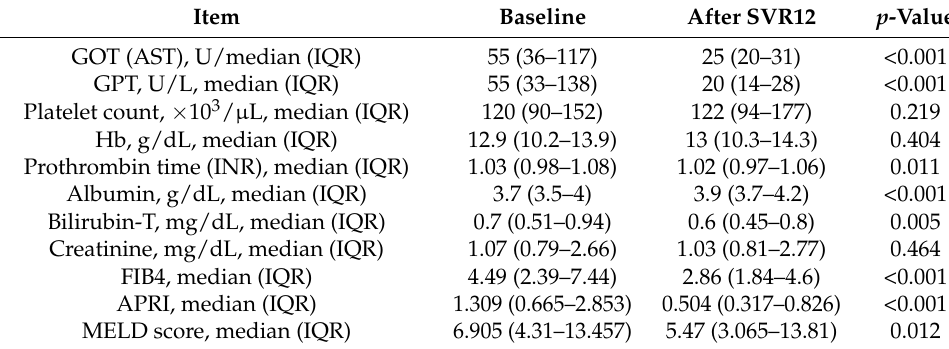
Table 4. Change in laboratory parameters after achieving